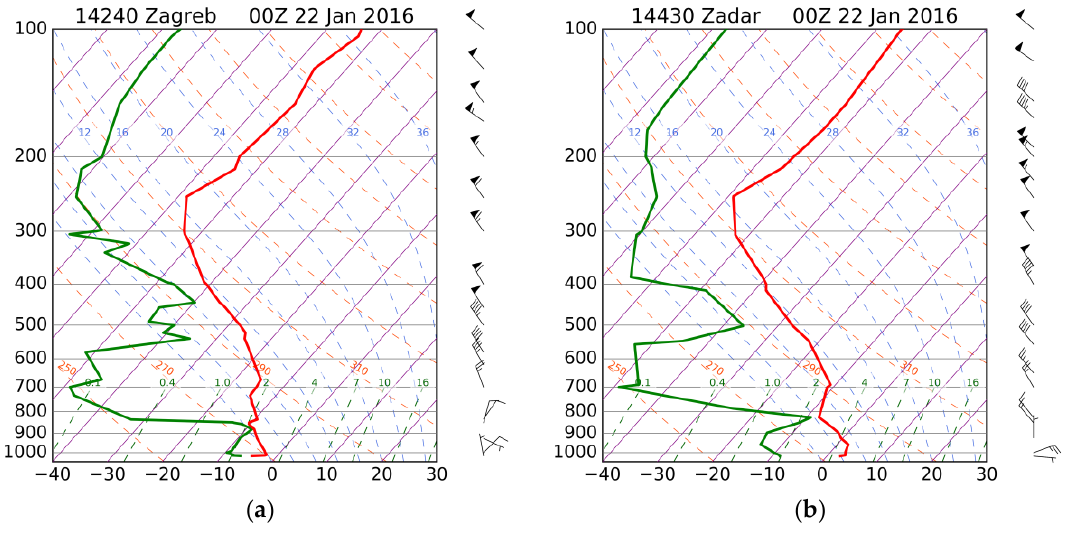
Figure 10. As with Figure 4, but for B13 (SA); 00 UTC on 22 January 2016.